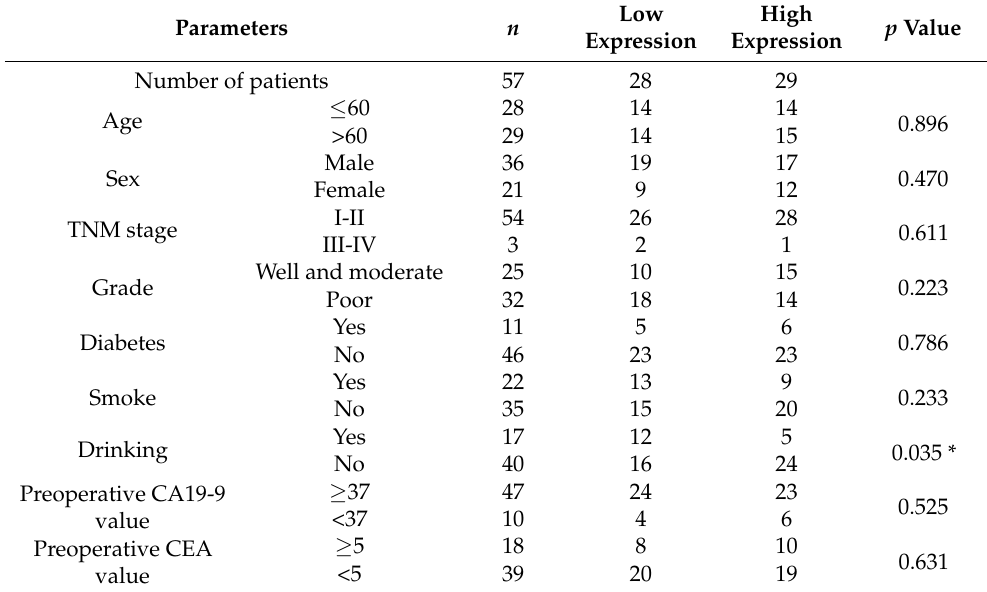
Table 1. Association of KLF6 expression and clinicopathologic parameters.